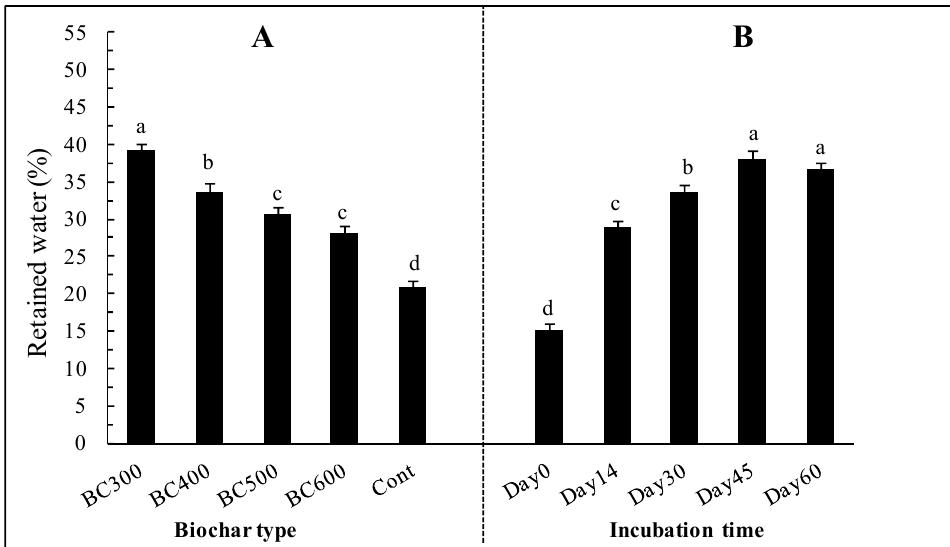
Figure 5. Percentage of retained water in sandy desert soil treated with 50 t ha − 1 of four date palm residue BCs produced with different pyrolysis temperatures (BC300, BC400, BC500, and BC600) averaged across the time of incubation ( A ) and incubation time averaged across the BC products( B ). Bars sharing the same letter among treatments are not significantly different according to the SNK test ( p ≤ 0.05). Errors bars represent the standard error of the mean.